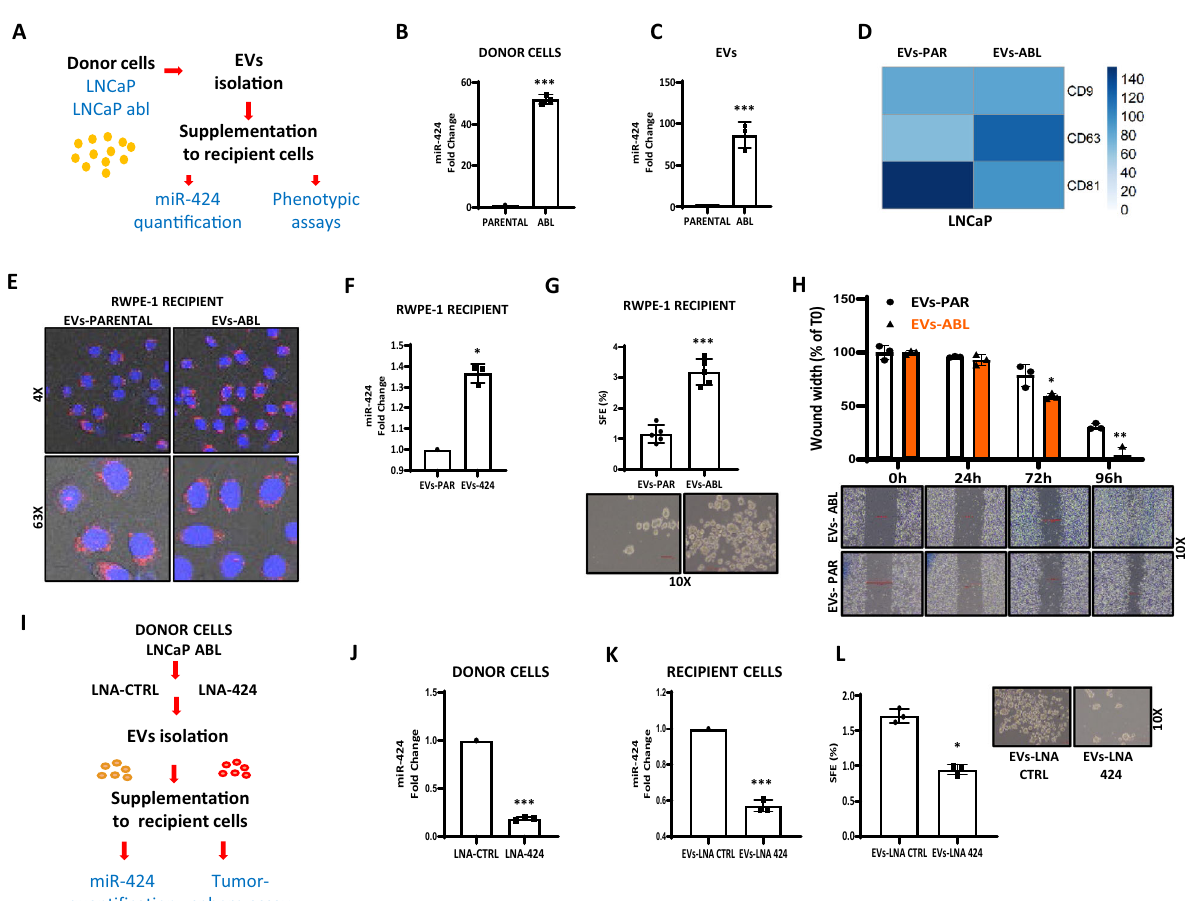
Fig. 4 EVs secretion of miR-424 is enhanced during the transition from indolent to aggressive phenotype in experimental models. A Isolation and assessment of EVs in LNCaP and LNCaP abl cells. B miR-424 expression in LNCaP and LNCaP abl cells. C miR-424 levels in EVs derived from parental LNCaP and LNCaP abl cells. D Surface markers in EVs from LNCaP (EVs-PAR) and LNCaP abl (EVs-ABL) cells. E Confocal images of RWPE-1 recipient cells incubated for 48 h with PKH26-labeled EVs (red) from LNCaP and LNCaP abl cells. Nuclei were stained with Hoechst (blue). F Level of miR-424 in recipient RWPE-1 after supplementation of EVs from parental (EVs-PAR) or LNCaP abl (EVs-ABL) cells. G Tumor-sphere formation by RWPE-1 cells supplemented with EVs from parental (EVs-PAR) or LNCaP abl (EVs-ABL) cells. H Cell migration by wound healing assay in recipient RWPE-1 cells incubated with EVs from parental (EVs-PAR) or LNCaP abl (EVs-ABL) cells. I Schematic of the experimental blockade of miR-424 transfer through EVs in LNCaP abl cells. J Level of miR-424 in LNCaP abl donor cells transfected with LNA-CTRL or LNA-424. K Level of miR-424 in recipient RWPE-1 cells supplemented with EVs from control (EVs-LNA CTRL) or LNA-transfected (EVs-LNA 424) donor cells. L Tumor-sphere formation by RWPE-1 recipient cells supplemented with EVs- LNA CTRL or EVs-LNA 424. * p ≤ 0.05, ** p ≤ 0.01, *** p ≤ 0.005 by two-tailed Student ’ s t promoted tumor-sphere formation (Fig. 5E) and cell migration (Fig. 5F), when supplemented to miR-424-negative recipient cells. Thus, tumor xenografts in mice secrete functional EVs that cells.